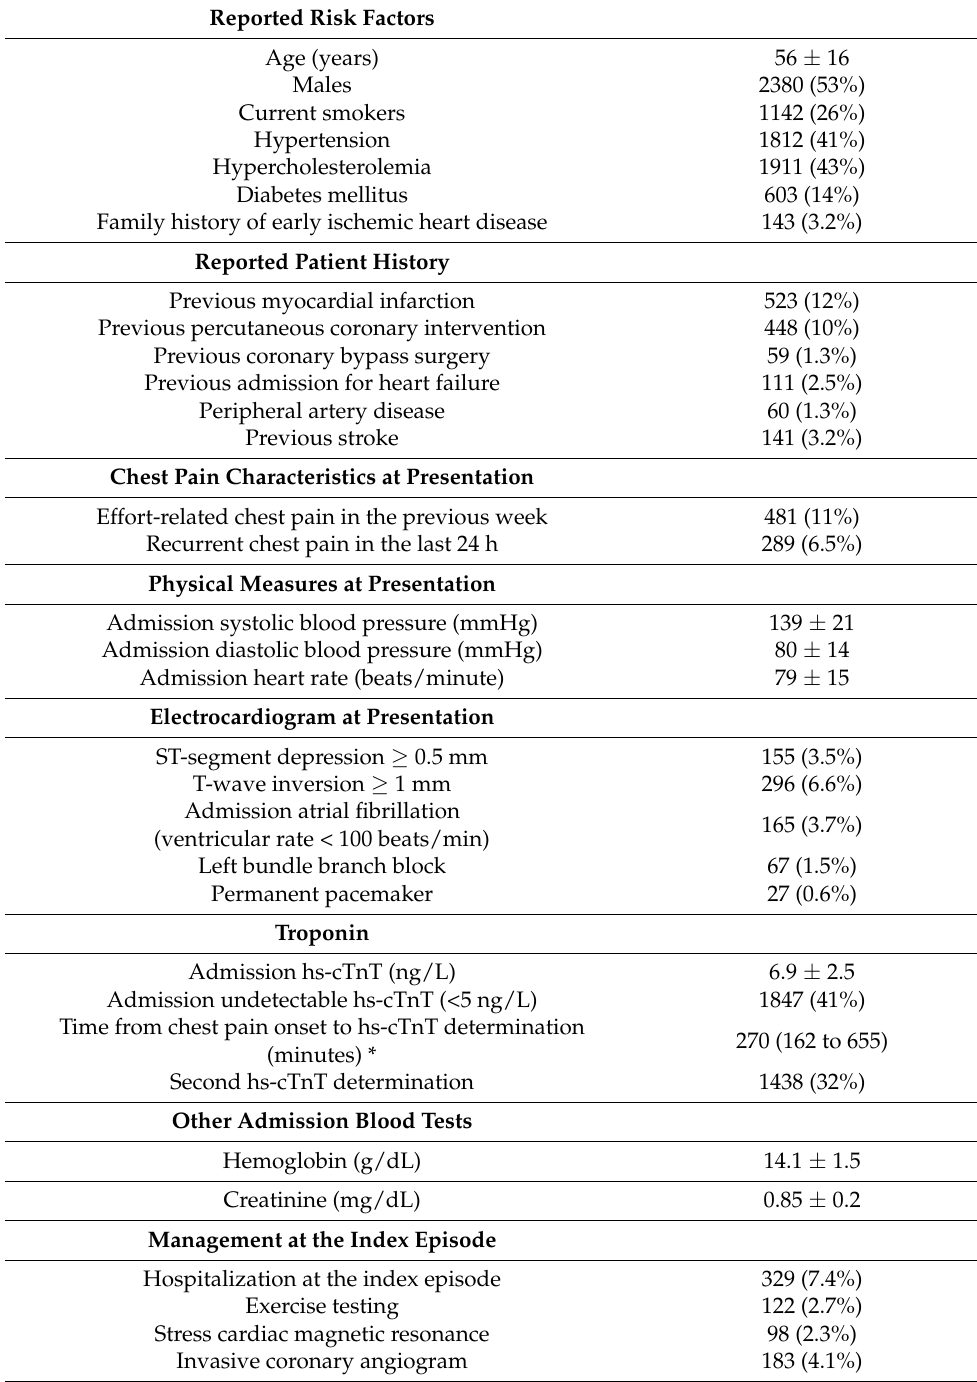
Table 1. Characteristics of the patient population ( n =